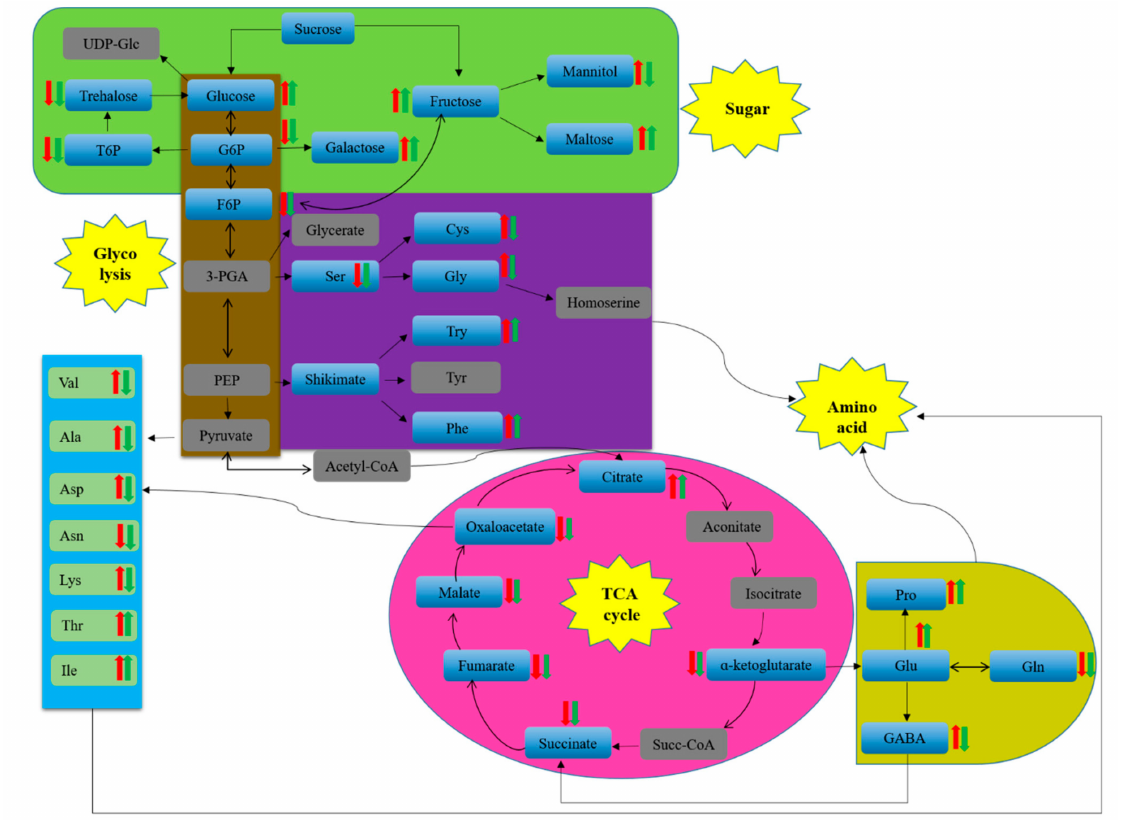
Figure 7. Schematic overview of some important metabolites and major metabolic pathways related to amino acid and energy metabolism in heat-stressed L. edodes mycelia. Strain 18 upregulation, strain 18 downregulation. Strain 18N44 upregulation, strain 18N44 downregulation. Gray indicates no significantly di ff erent